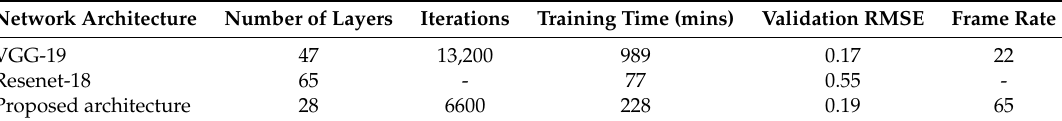
Table 2. Comparison of the different network